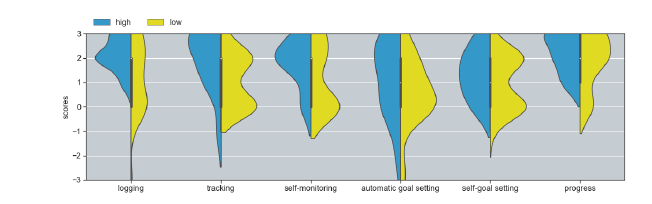
Figure 4. Motivational design techniques regarding awareness & personal insights.